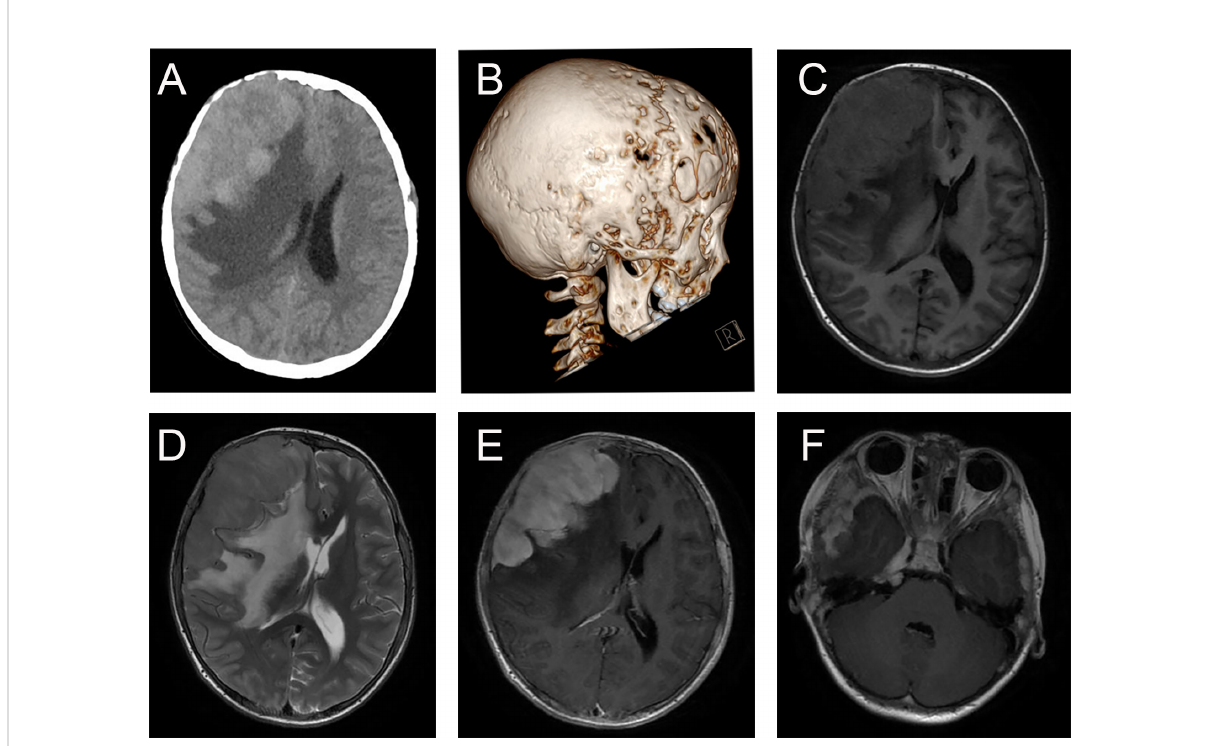
FIGURE 1 Typical imaging features of CNS-RDD (case 9). (A, B) CT images of axial cut and three-dimensional reconstruction showed destruction of the adjacent right frontal bone and a homogenous hyperattenuating mass with peripheral edema. MRI images with axial cuts show a homogeneous hypo- to the isointense mass of the right frontotemporal lobe on T1WI (C) and T2WI (D) , with signi fi cant homogeneous enhancement and dural attachment (E) . (F) Axial postcontrast T1WI showed CNS-RDD could also involve the right parasellar region.